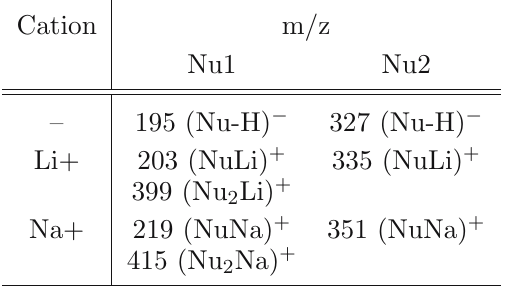
Table 2 ESI mass spectrometry data for complexes of nucleophiles with lithium or sodium